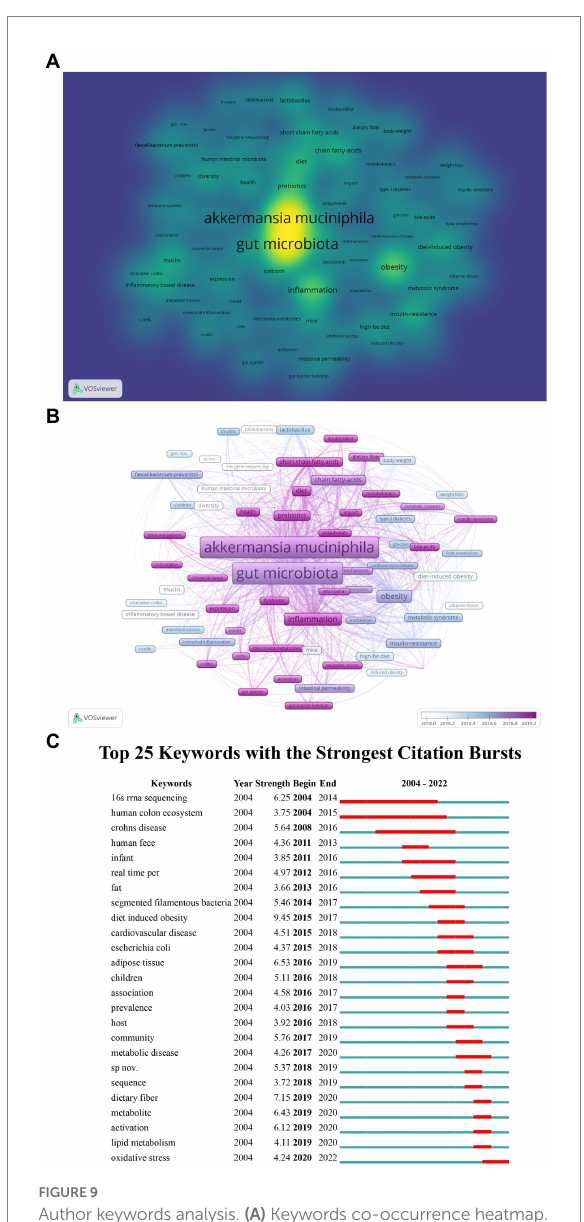
FIGURE 9 Author keywords analysis. (A) Keywords co-occurrence heatmap. The heatmap color and size reflect the frequency of keywords. (B) Overlay visualization of A. muciniphila -related keywords. Each node represents a different author keyword. The color of the nodes corresponds to the average year in which the keyword appeared according to the color gradient shown at the bottom right. (C) Top 25 A. muciniphila- related keywords with the strongest citation bursts